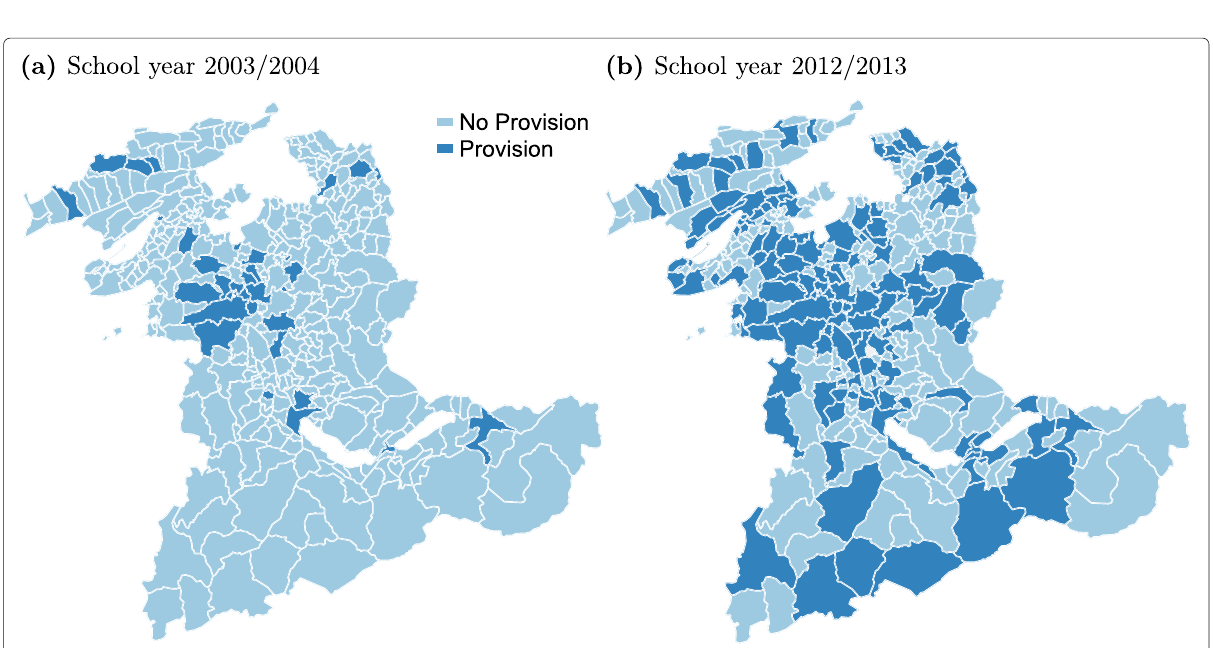
Fig. 4 Prevalence of lunchtime and after-school care in the canton of Bern before and after the introduction of the new regulation. Light blue areas show municipalities which do not offer lunchtime or after-school care in the given period, whereas dark blue areas show municipalities with lunchtime and after-school care in the given